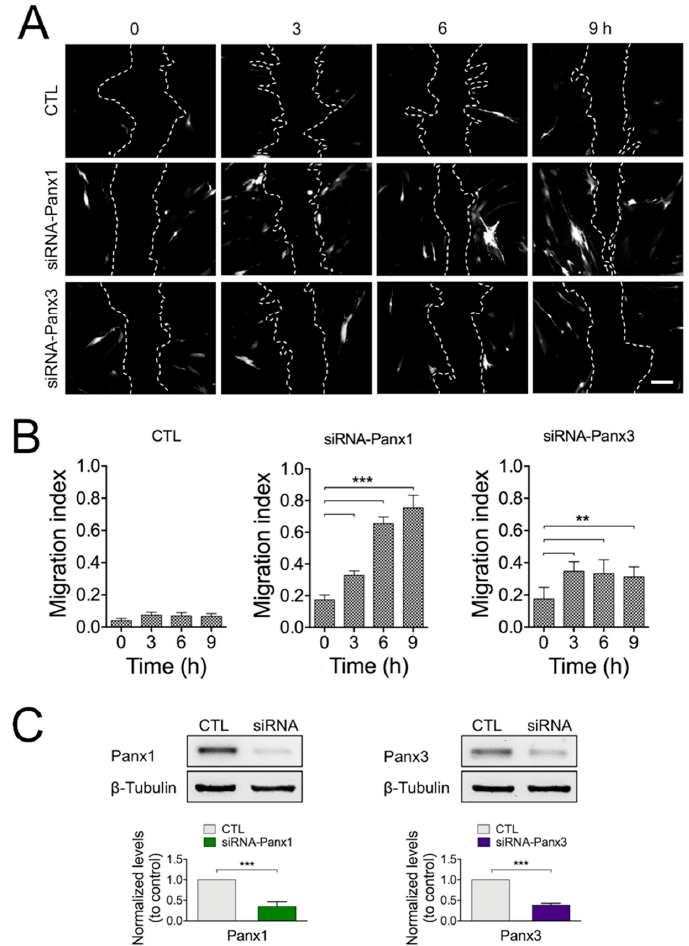
Figure 2. siRNA against Panx1 increases the migration index in HDF cultures. ( A ) Representative images of the wound healing process in cultures using Panx1 or Panx3 knockdown cells. HDFs transfected with siRNAs against Panx1, Panx3, or the control plasmid (CTL; siRNA-Empty-GFP) were identified by GFP expression. Dashed lines indicate the wound area (or the migration front line). Bar: 200 µM. Supplementary Figure S1B shows these same fluorescent images superimposed with their respective bright-field images. ( B ) Quantitative analysis of the average migration index 24 h after transfection of HDFs with respective siRNAs and CTL plasmid. Statistical significance ** p = 0.011; *** p < 0.001; n = 10 experimental replicas from 4 different cultures (one-way ANOVA followed by Tukey’s post hoc test). ( C ) Representative Western blots of Panx1 and Panx3 expression levels in total lysates from HDFs 12 h post-transfection. Graphs depicting the relative amount of Panx1 and Panx3 normalized to β -Tubulin from 4 different cultures. *** p < 0.001 for siRNA fibroblasts compared to control (unpaired two-tailed t -test). All data are shown as mean ±